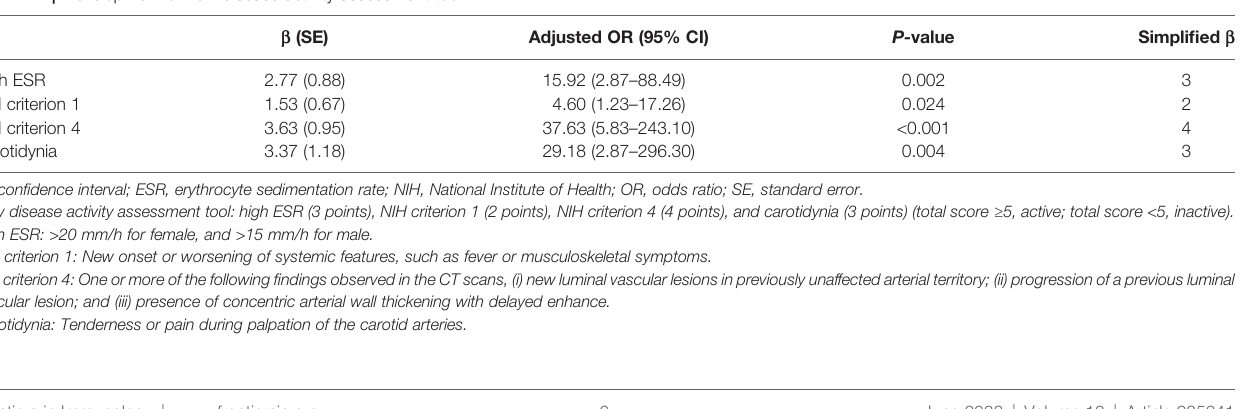
TABLE 4 | Development of new disease activity assessment